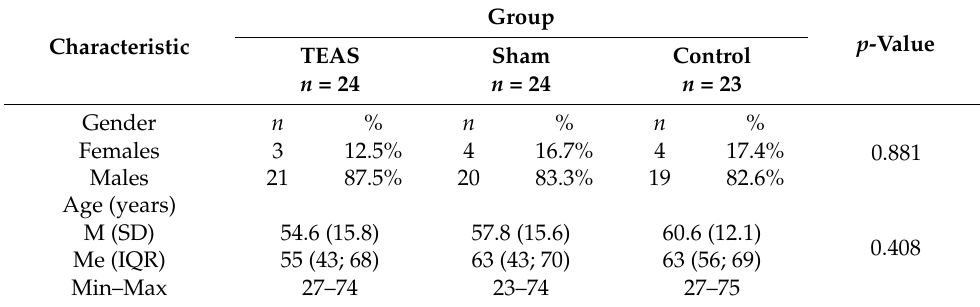
Table 1. Baseline characteristics of patients in randomized groups.